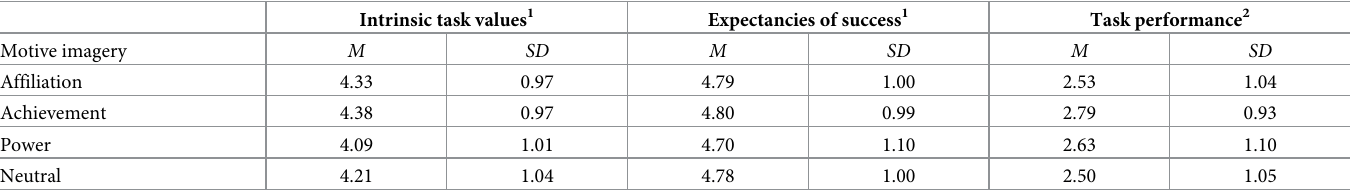
Table 5. Means and standard deviations for intrinsic task values, expectancies of success and performance in neutral tasks, and tasks related to affiliation, achieve- ment, and power in Experiment